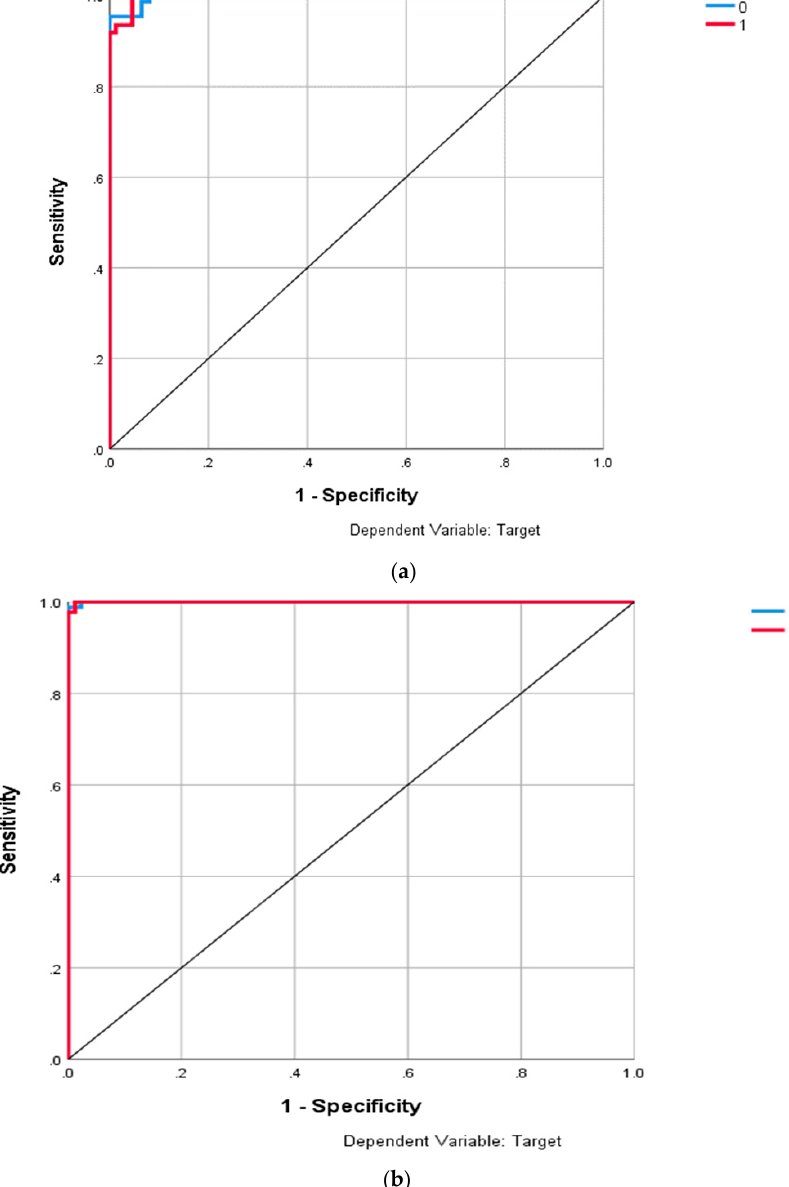
Figure 4. ( a ) Network sensitivity for gains (top); ( b ) network sensitivity for falls